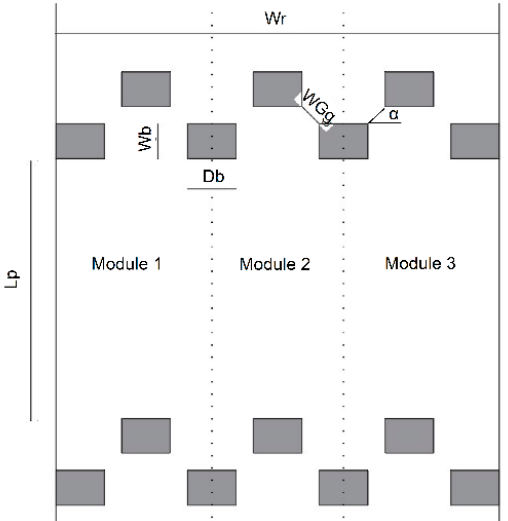
Figure 3. Details of a pool and a rock-row geometry of rectangular boulder layout (R3).